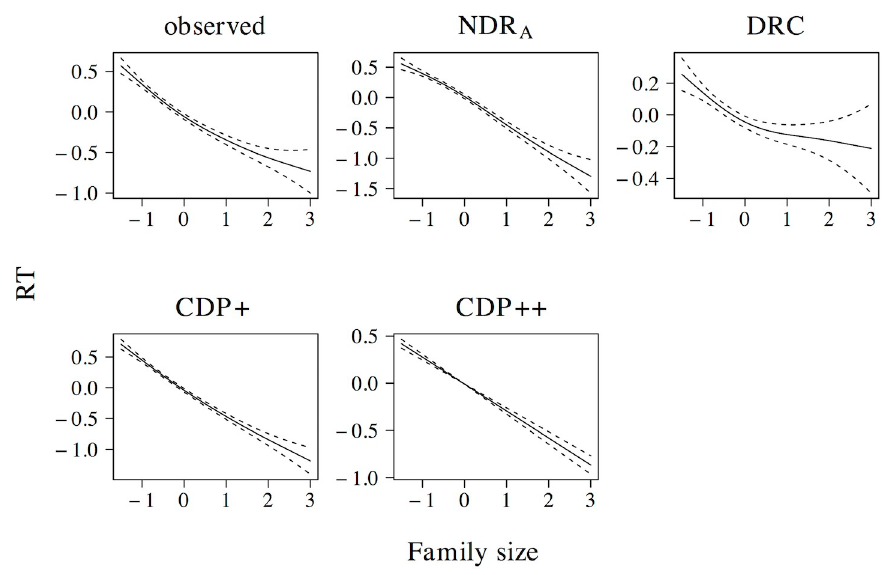
Fig 21. Family size. The effect of family size in word naming.